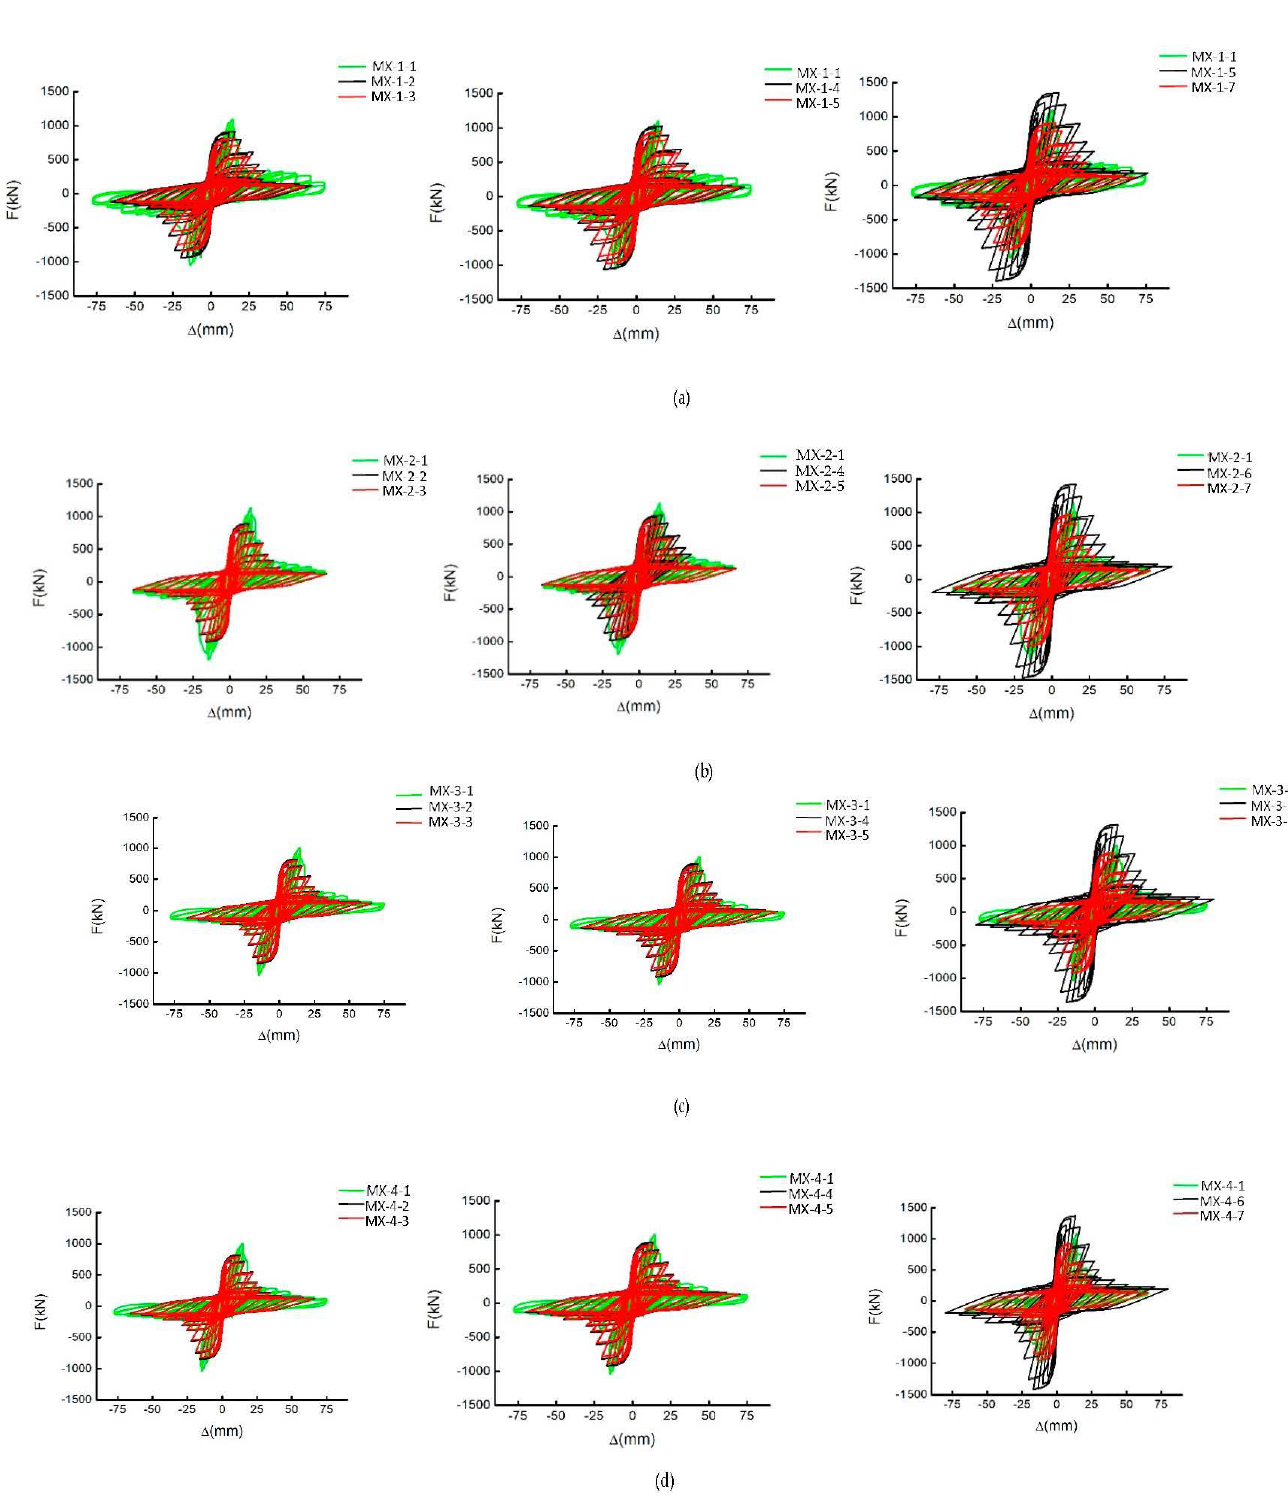
Figure 7. Effects of varying parameters on the hysteresis characteristics of the composite wall struc- ture: ( a ) First ( b ) second, ( c ) third, and ( d ) fourth group of virtual test pieces.